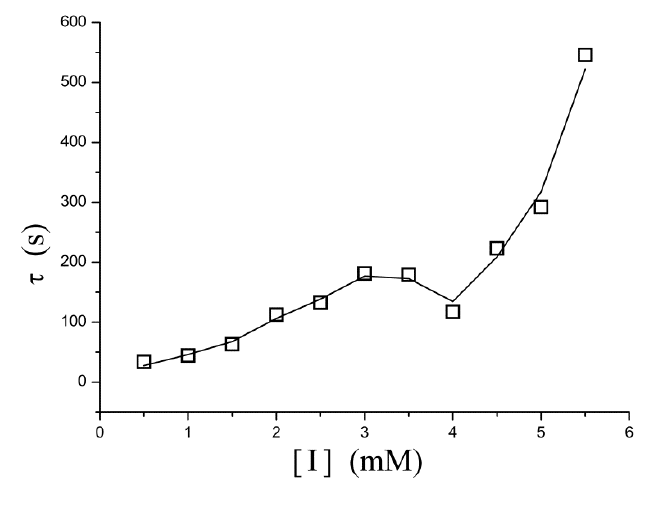
Figure 5. Effect of the concentration of phenylhydrazine inhibitor on the relaxation time during pre-steady-state phase. It increased exponentially with increase in concentration. A “depression” appears on the curve in the concentration of 3 − 4